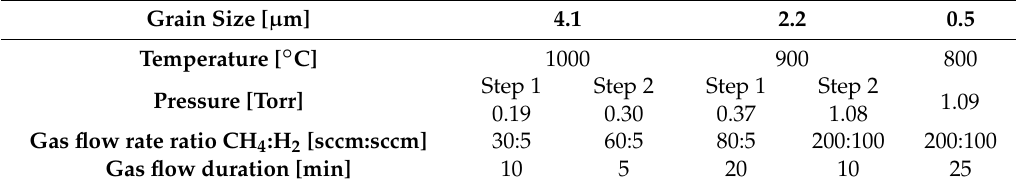
Table 1. CVD graphene synthesis conditions for three different grain